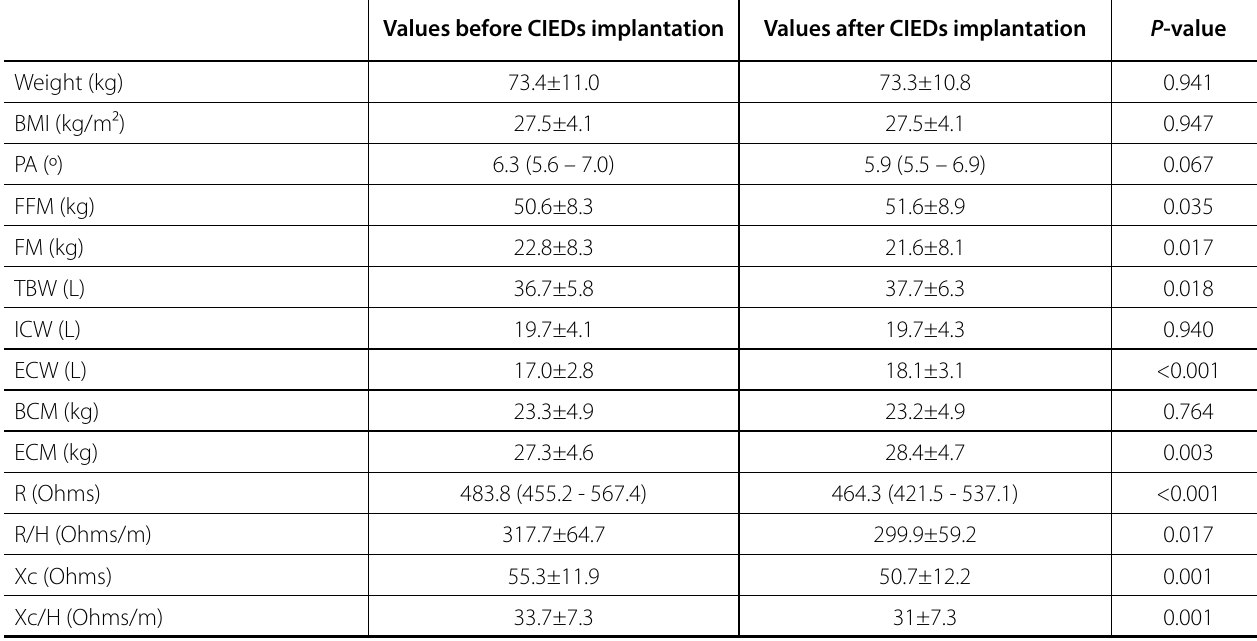
Data described as mean and standard deviation or median and interquartile interval (P25-P75). BCM=body cell mass; BIA=bioelectrical impedance analysis; BMI=body mass index; CIEDs = cardiac implantable electronic devices; ECM=extracellular mass; ECW=extracellular water; FFM=fat-free mass; FM=fat mass; H=height; ICW=intracellular water; PA=phase angle;